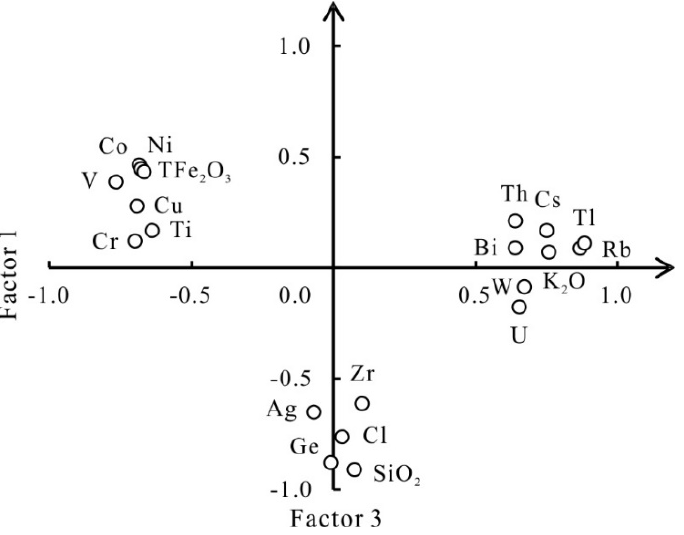
Figure 10. Biplot of Factor 1(Bi − Th − U − W − Cs − K 2 O − Rb − Tl − (V − Cr − Cu − Ni − Co − Ti − TFe 2 O 3 ) association) vs. Factor 3 (SiO 2 − Ge − Cl − Ag − Zr association). Circles indicate